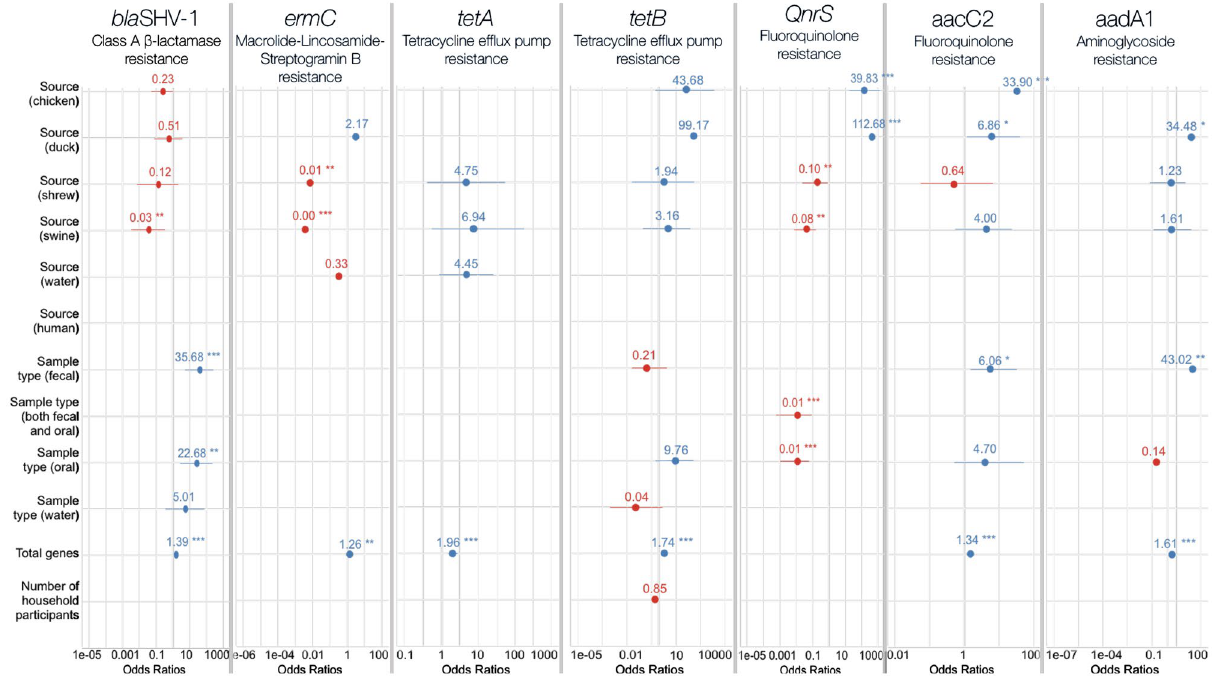
Figure 1. Logistic regression output of predictors associated with the detection of antibiotic resistance genes of public health importance in an urban informal settlement in Kathmandu, Nepal, 2017. Odds ratios and 95% confidence intervals indicated by point and line for each variable across models; specific results can be found in SI Table 1. Asterisks denote p-values (*p < 0.05, **p < 0.001, ***p < 0.0001). Colors indicate a protective (red) or risk (blue) factor (OR < 1 vs. > 1). Odds ratio scales shown at the bottom of each graph and vary by model. Not all variables were assessed in each model; see “Methods” section for specifics. bla SHV‑1 and tetB were mixed effects models and only fixed effect output is shown. Fecal samples comprise rectal swabs (swine, rodents, shrews), cloacal swabs (ducks, chickens), and feces (humans). Total genes serves as a proxy for co-occurrence of genes in the sample, as measured by total number of genes (out of N = 88) positive in the